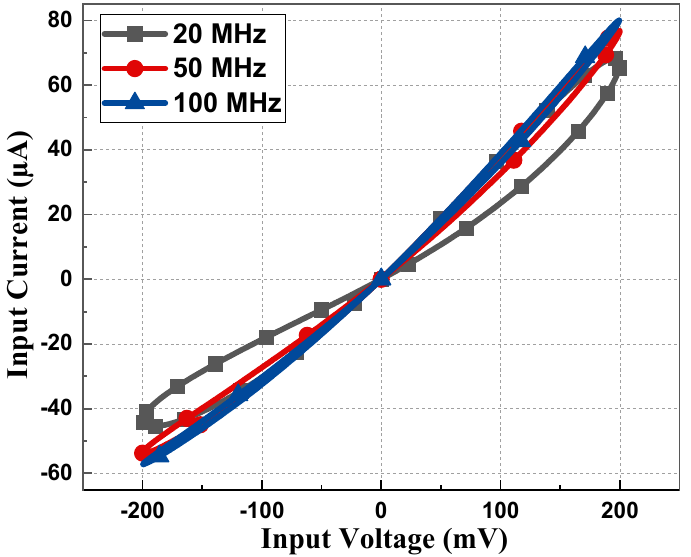
Figure 7. PHL at 20, 50, and 100 MHz with 5 pF capacitor value for incremental configuration.